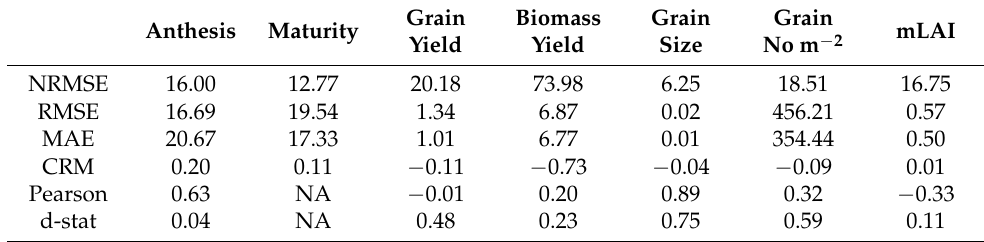
Table 14. Results of the validation statistics for the APSIM-Maize model under irrigated conditions.